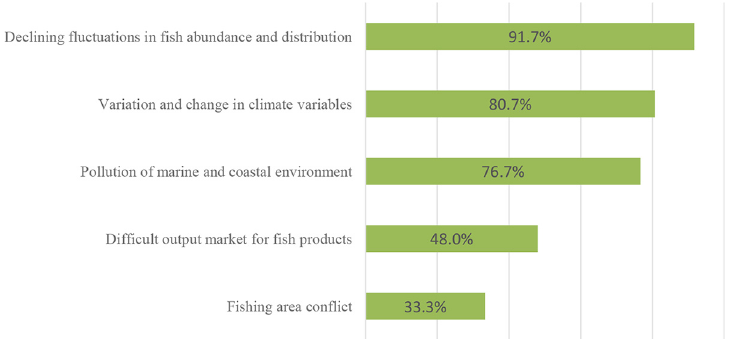
being experienced by fi shing households